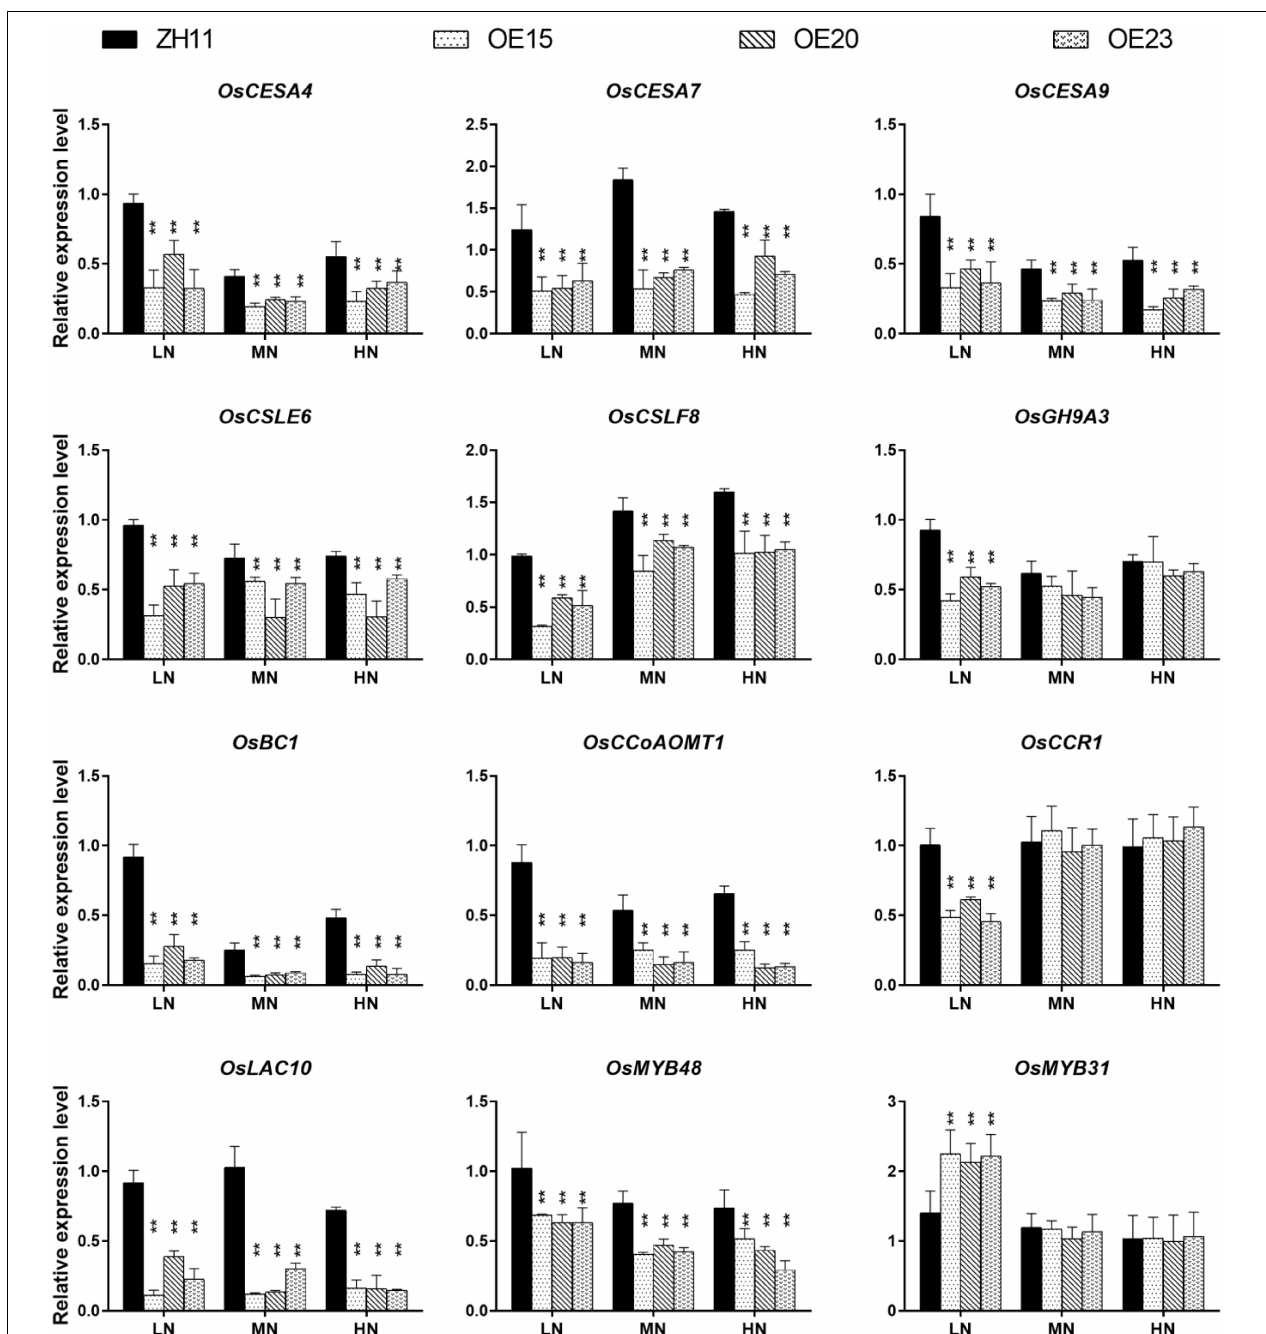
FIGURE 6 | The expression level of cellulose and lignin synthesis related genes in the roots of OsMYB305 -OE lines (OE15, OE20, OE23) and WT (ZH11) growing under various N treatments. Values were means ± SD of 3 biological replications. Statistical significance was determined using Student’s t -test (** P <